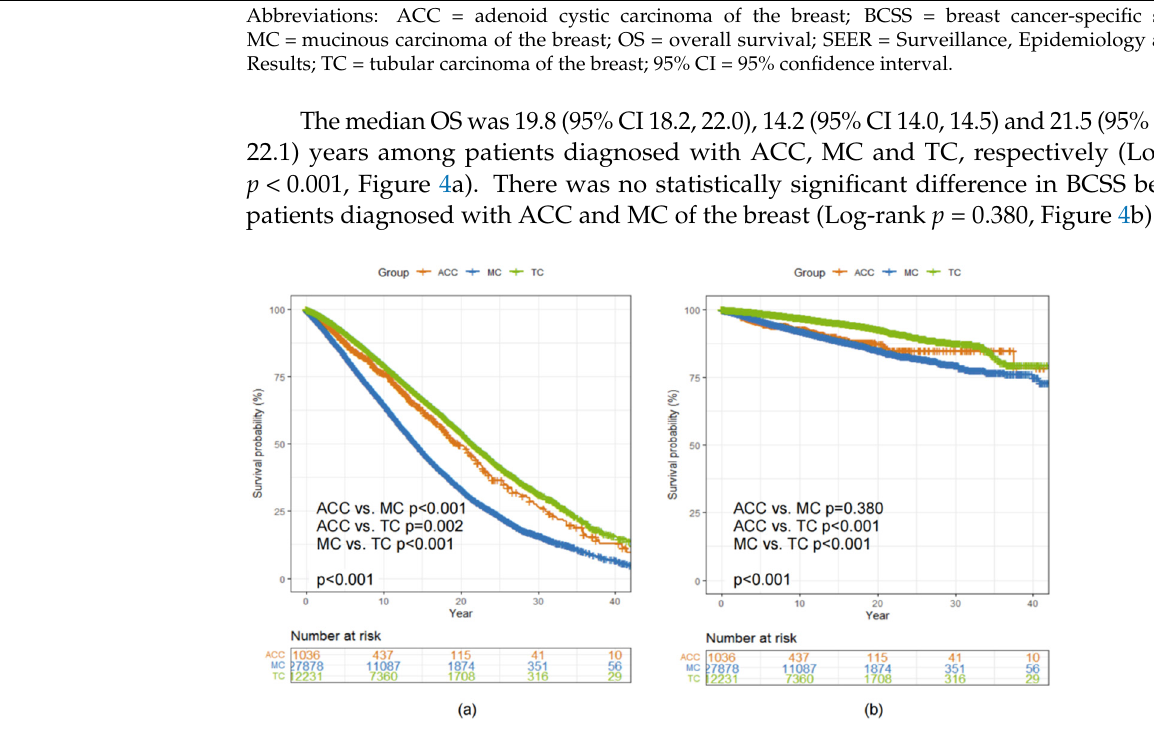
Figure 4. Kaplan–Meier curves showing a comparison of ( a ) OS and ( b ) BCSS among patients with ACC, MC and TC of the breast. Abbreviations: ACC = adenoid cystic carcinoma of the breast; BCSS = breast cancer-specific survival; MC = mucinous carcinoma of the breast; OS = overall survival; TC = tubular carcinoma of the breast.